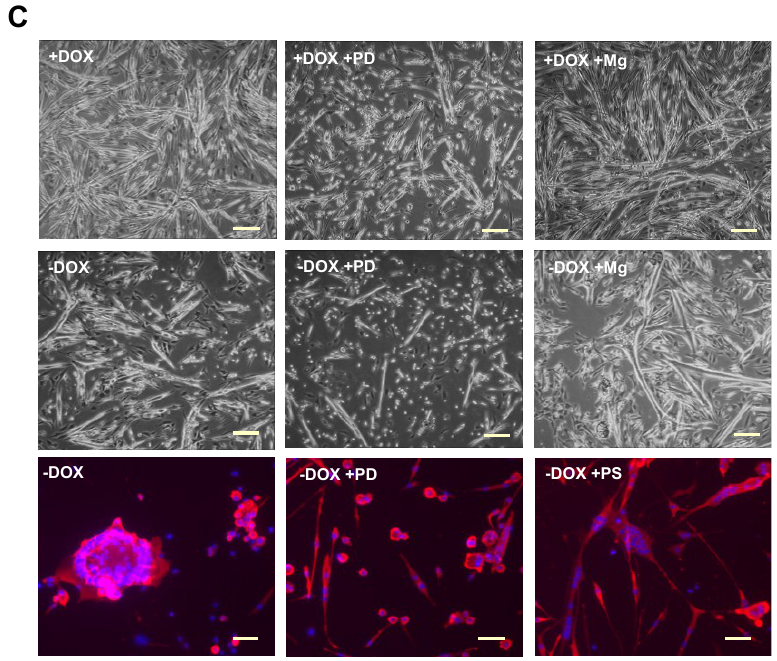
Figure 3. Changes of MyHC content and morphology in myotubes after treatment with MAPK pathway and proteasome inhibitors. ( A ) MyHC and phospho-Erk1,2 were analyzed and quantified by western blot of the lysates from uninduced (+DOX, white and light grey columns) and induced (−DOX, black and dark grey columns) myotubes cultured in the absence (white and black columns) or in the presence (light and dark grey columns) of the PD098059 inhibitor (PD) of the MAPK pathway. Values are the mean ± SD of three independent experiments and are expressed as the fold relative to the +DOX control (white column). Representative images of MyHC, PErk1,2 and total Erk2 are shown on the right. Tubulin was used as the loading control. For the MyHC experiment, a t -test was evaluated comparing +DOX vs. −DOX and −DOX vs. −DOX + PD samples. The t -test of PErk1,2 WB was calculated between +DOX vs. +DOX + PD and between −DOX vs. −DOX + PD. * p < 0.05, *** p < 0.005; ( B ) Analysis of MyHC in the western blot of the lysates from uninduced (+DOX) and induced (−DOX) myotubes, grown in the absence or in the presence of the Mg132 proteasome inhibitor (Mg); ( C ) Differentiated myotubes with or without induction of Tpr–Met were either untreated (left panels), treated with PD098059 (+PD, middle panels), or treated with inhibitors of the proteasome: Mg132 (+Mg, upper and middle right panels) and PS-341 (+PS, lower right panel). The upper and middle panels are optical images of myotubes cultured for three days in DM. The bottom panels are immunofluorescence images of myotubes cultured for five days in DM. Red, MyHC; blue, DAPI . Scale bars: 500 µm (upper and middle panels) and 100 μm (bottom